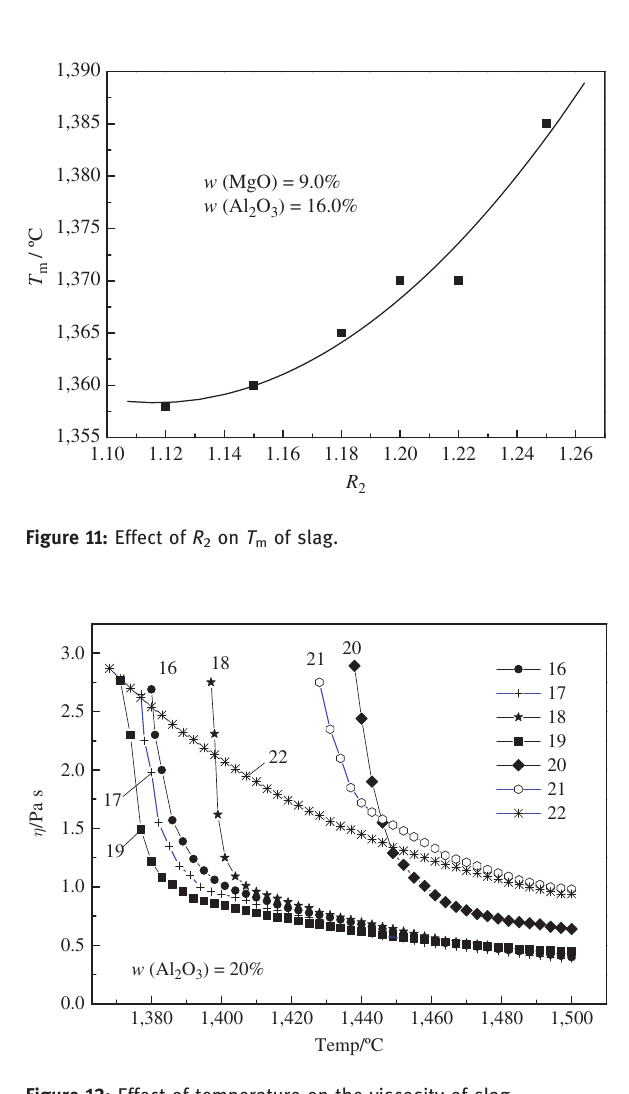
Figure 10: Effect of R 2 on viscosity of slag.